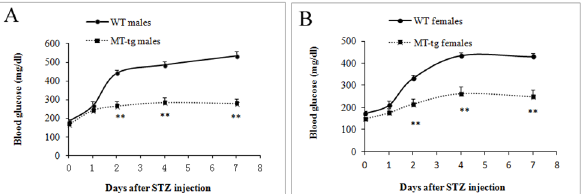
Fig 2. Blood glucose levels in MT-tg and WT mice after in vivo STZ treatment. (A) MT-tg (n = 8) and WT (n = 7) male mice; (B) MT-tg (n = 13) and WT (n = 21) female mice. * p < 0.05, ** p < 0.01 vs WT.